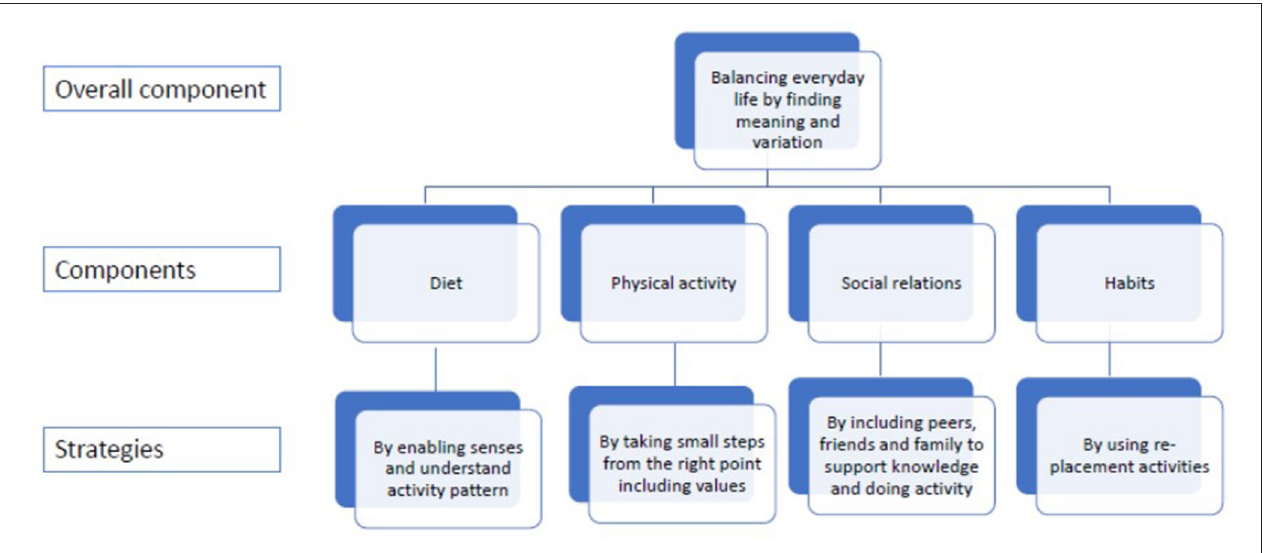
FIGURE 1 | The relations between components and